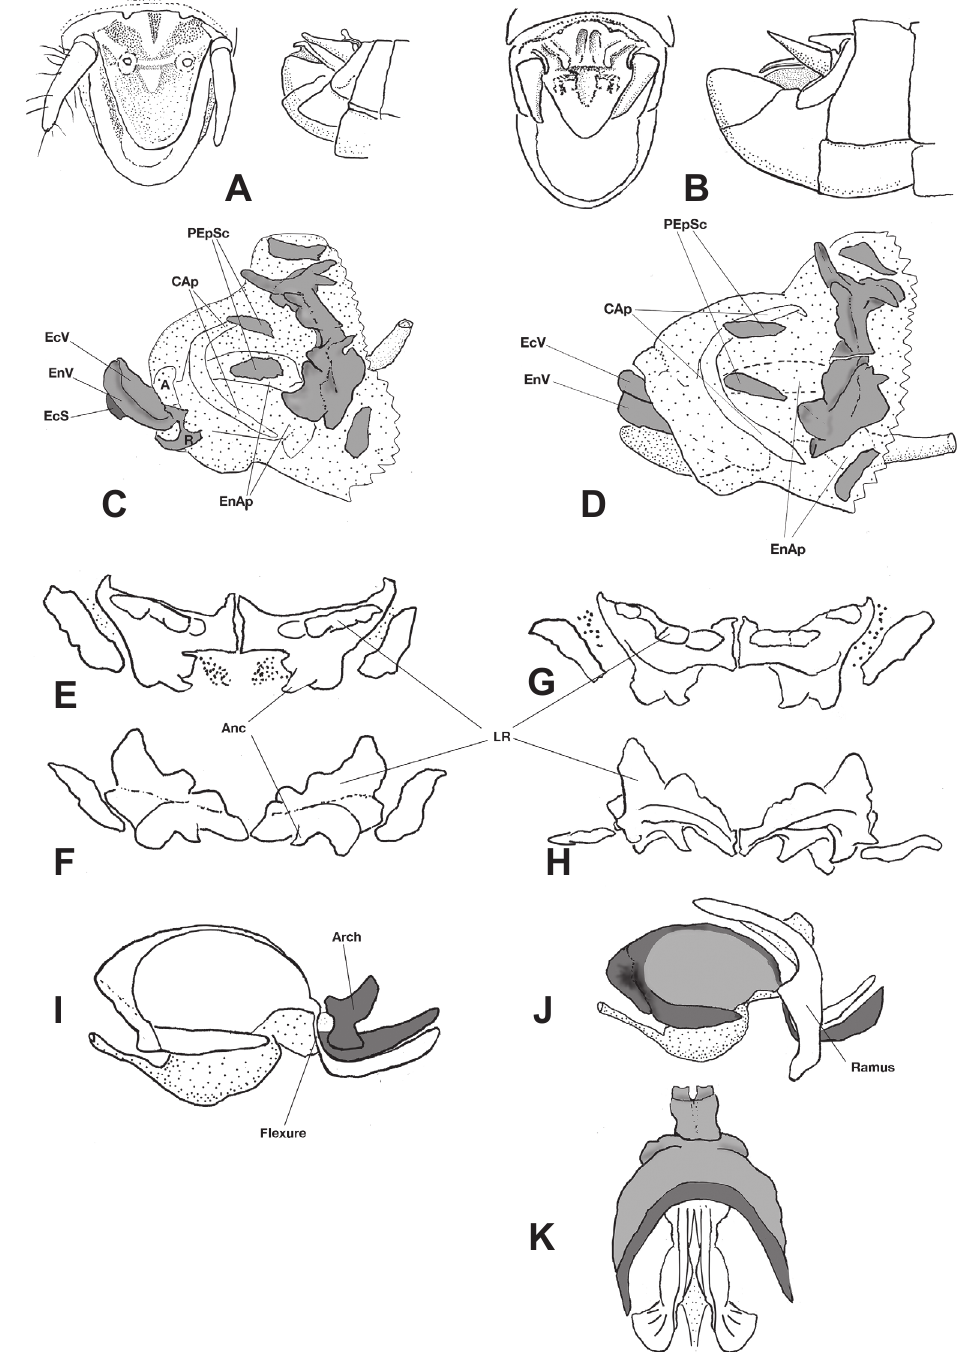
Fig. 6. A , C , E , F , and I are Burttia sylvatica ; B , D , G , H , J , and K are B. caerulea sp. nov. A. Burttia sylvatica , male terminalia in dorsal and lateral views; B as A but B. caerulea sp. nov.; C. ( B. sylvatica ); and D. ( B. caerulea sp. nov.). Oblique dorso-lateral view of entire phallic complexes. Membrane is shown dotted. The shaded sclerites are the epiphallus and its lateral “oval” sclerites (unlabelled, at the right- hand edge of each figure), the paired post-epiphallic sclerites (PEpSc), the right-hand side ectophallic ramus (R) in C only, and the aedeagal valves (EcV, ectophallic (dorsal) aedeagal valve; EnV, endophallic (ventral) aedeagal valve; EcS, fragment of ectophallic sheath left adhering to ventral valve during dissection). The remaining sclerites are indicated only by outlines, indistinctly visible through the membrane (A, arch; CAp, cingular apodemes; EnAp, endophallic (basal) apodemes). E, F. Burttia sylvatica , epiphallus; E. dorsal view; F. axial view. Note trilobed lophal ridge (LR), divided epiphallic bridge, and large irregularly shaped “oval” sclerites and inwardly directed ancorae (Anc). G and H as E and F but B. caerulea sp. nov. Phallic complex with ectophallic membrane, zygoma, cingulum, and rami removed to expose the arch and the endophallic flexure. Arch and LHS ectophallic valve shaded. J. Burttia caerulea sp. nov. Phallic com- plex with ectophallic membrane removed, showing endophallus, cingulum with LHS ramus and LHS ectophallic valve. Endophallus shaded. K as J but dorsal view. Ectophallic elements